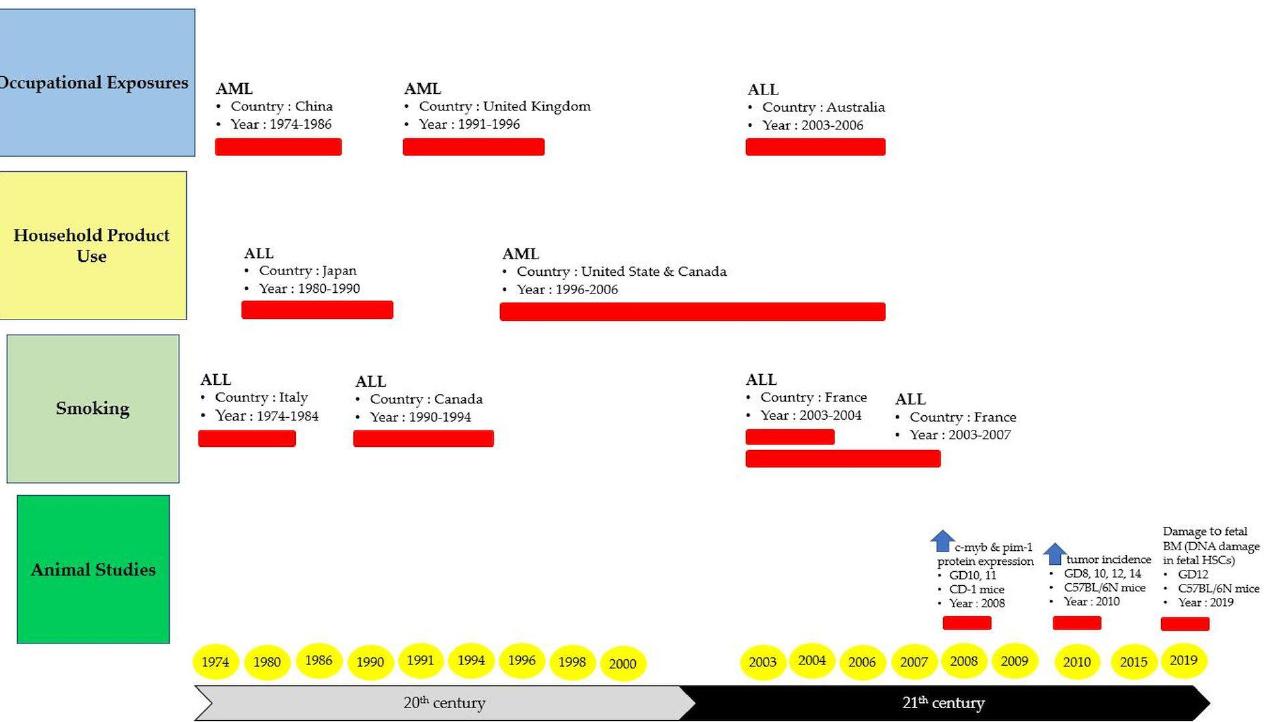
Figure 3. Summary of the studies addressing the incidences of childhood leukemia in relation to maternal exposure to benzene during pregnancy. Abbreviations: ALL: acute lymphocytic leukemia; AML: acute myeloid leukemia; DNA: deoxyribonucleic acid; GD: gestation day; HSCs: hematopoietic stem cell.